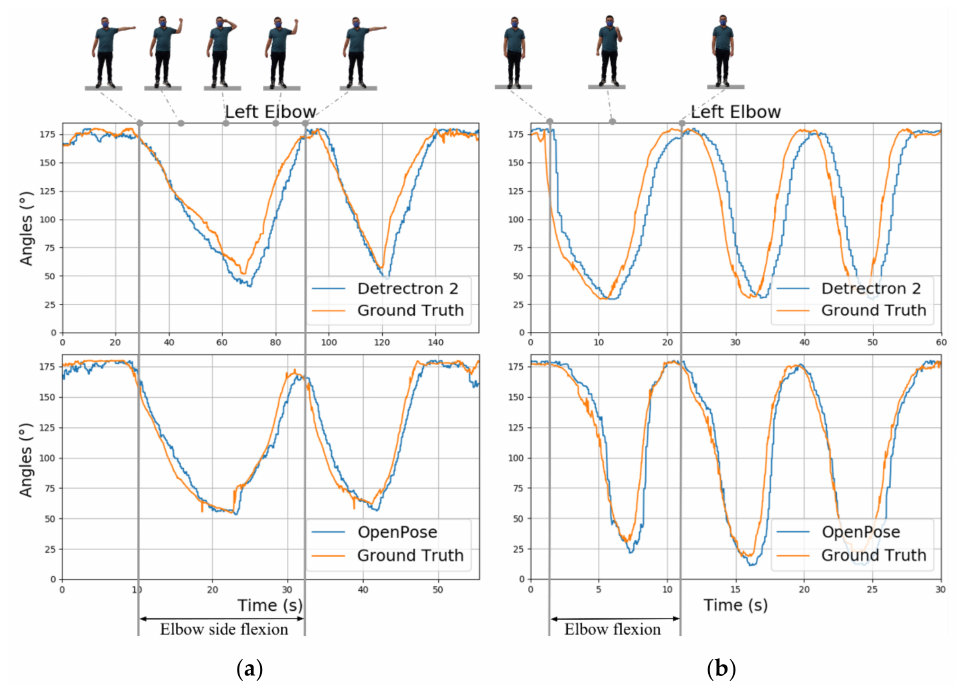
Figure 7. Exercise 1: elbow side flexion angles for two iterations ( a ); exercise 2: elbow flexion for three iterations ( b